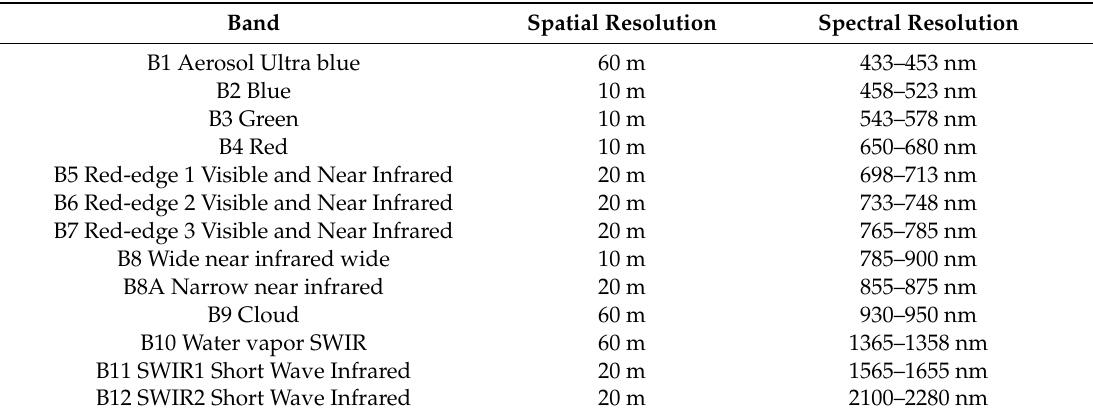
Table A2. The characteristics of the Sentinel-2